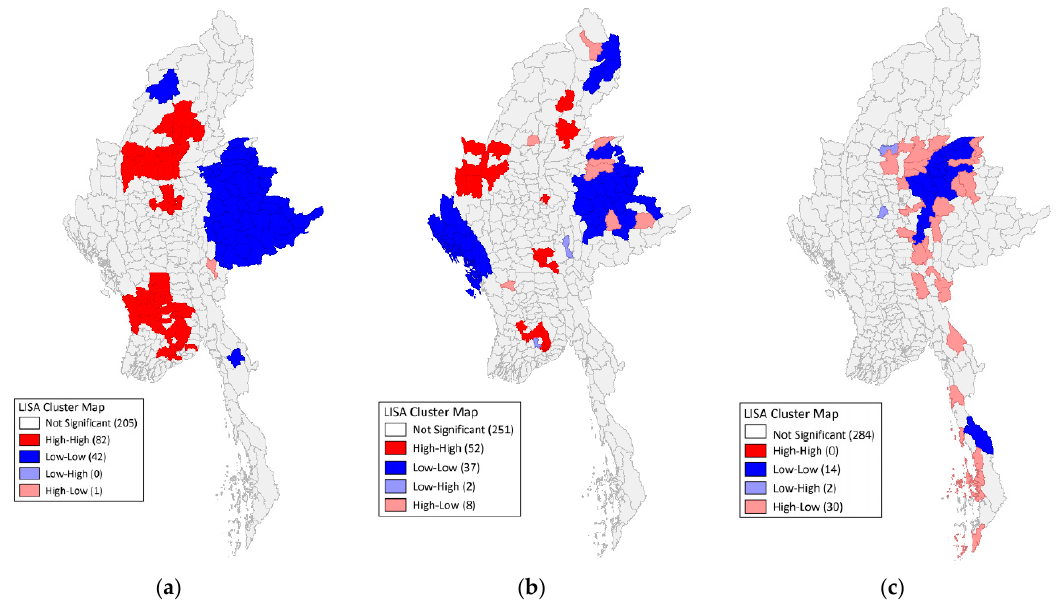
Figure 2. ( a ) Local Indicators of Spatial Association (LISA) Cluster Map of Adult Literacy at the Geographic Level of Myanmar Townships. ( b ) LISA Cluster Map of Access to Safe Sanitation at the Geographic Level of Myanmar Townships. ( c ) LISA Cluster Map of Lead Mining at the Geographic Level of Myanmar Townships.